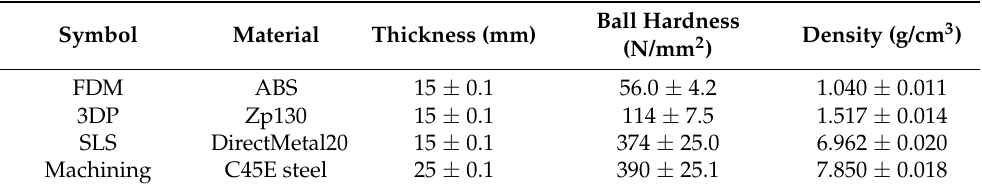
Table 2. Selected physical properties of non-circular